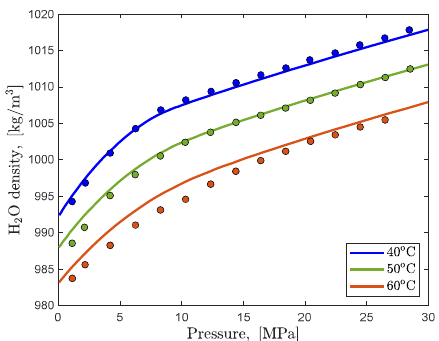
Figure 7. Molar volume of CO 2 as a function of temperature and pressure. The discrete points are experimental data presented in [52], and the continuous lines are calculated by the simulator.